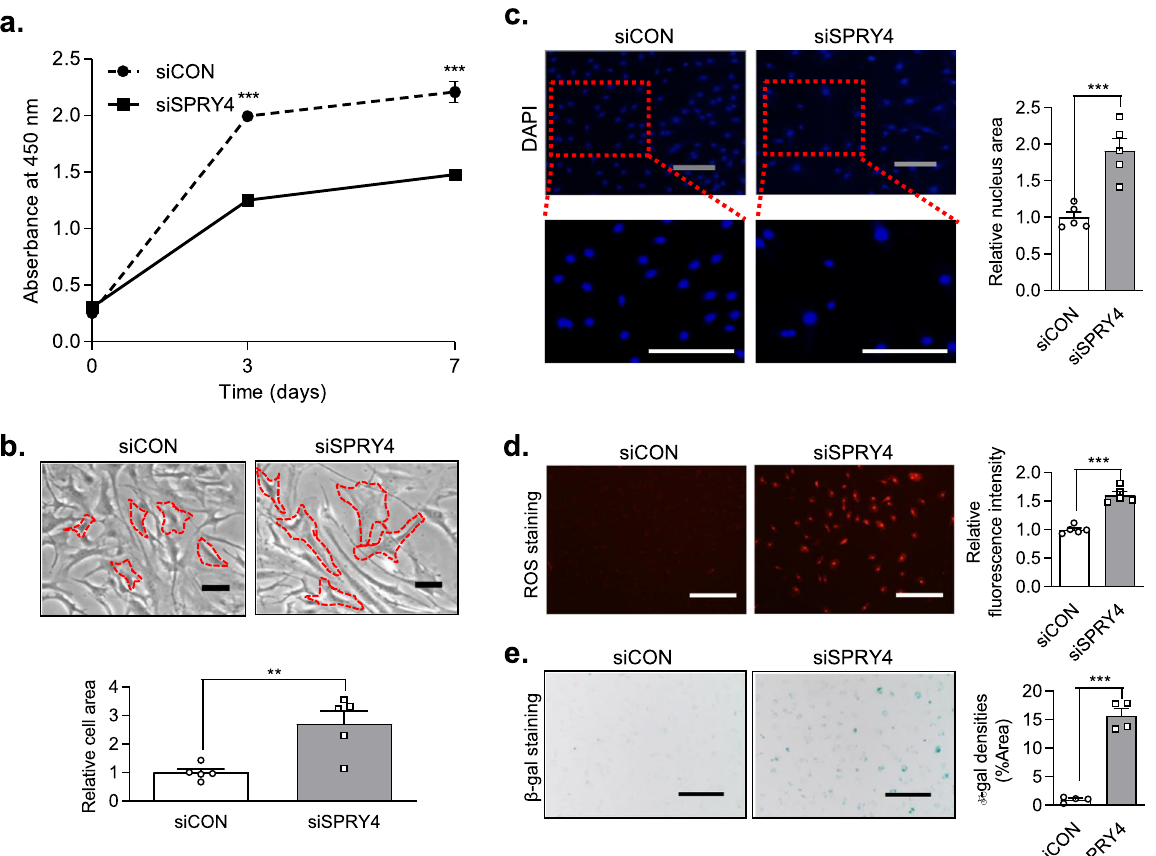
Fig. 2 Effect of SPRY4 suppression on chondrocyte hypertrophy in HCs. a CCK-8 cell proliferation assay of siCON-treated and siSPRY4- treated HCs by time ( n = 3, unpaired t -test with Welch ’ s correction). b Microscopic images of siCON-treated and siSPRY4-treated HCs ( n = 5, unpaired t -test) Scale bars, 100 μ m. c DAPI staining of siCON-treated and siSPRY4-treated HCs ( n = 5, unpaired t-test with Welch ’ s correction) Scale bars, 100 μ m. d ROS staining of siCON-treated and siSPRY4-treated HCs ( n = 5, unpaired t -test with Welch ’ s correction) Scale bars, 250 μ m. e β -gal staining of siCON-treated and siSPRY4-treated HCs ( n = 4, unpaired t -test) Scale bars, 250 μ m. All data represent the mean ± SEM. Abbreviations: CCK-8, cell counting kit-8; DAPI, 4 ′ ,6-diamidino-2-phenylindole; ROS, reactive oxygen species; β -gal, β